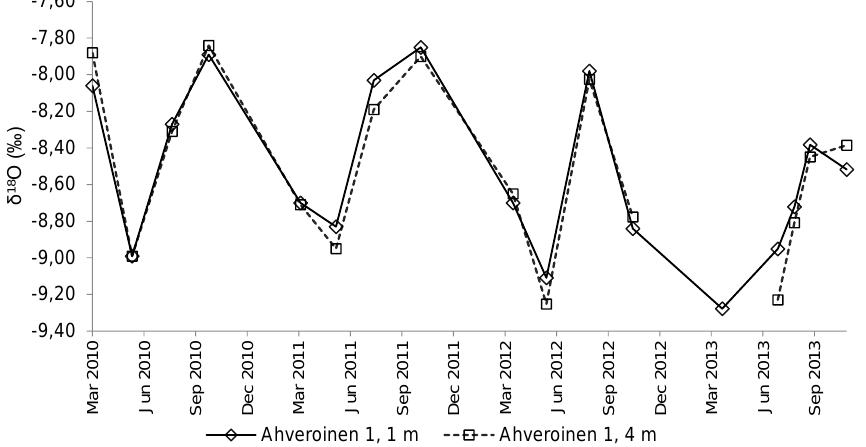
Figure 6. Seasonal variations of δ 18 O in lake Ahveroinen 1, observed at 1 and 4m depth. Maximum depth of the lake is